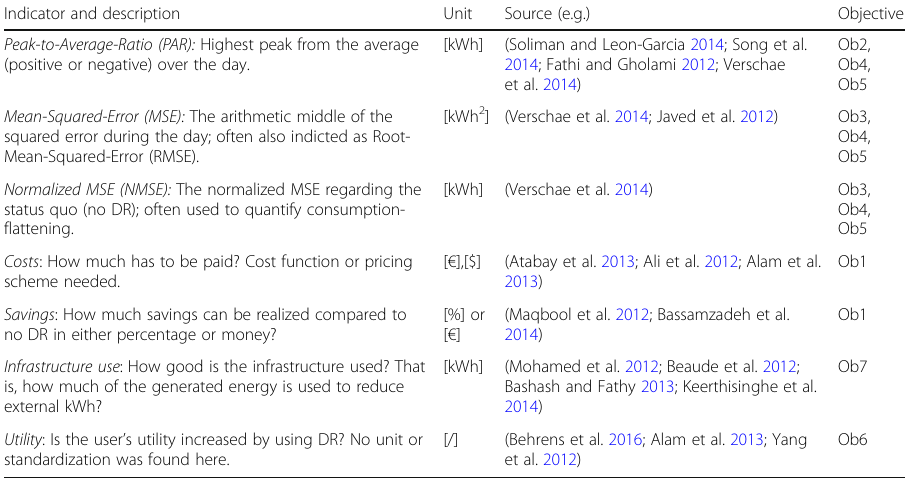
[kWh] (Soliman and Leon-Garcia 2014; Song et al. 2014; Fathi and Gholami 2012; Verschae et al. 2014)